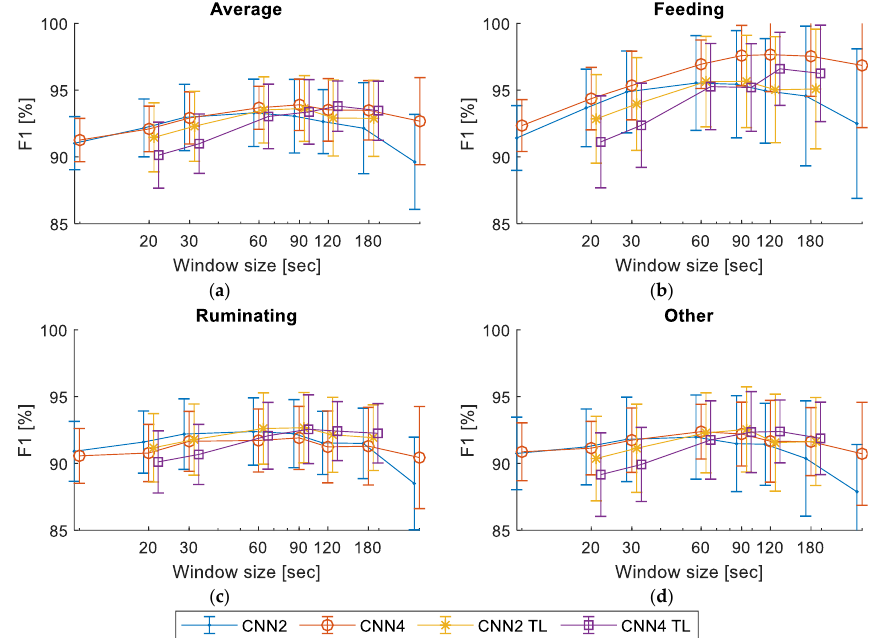
Figure 6. Performance of the tested models, CNN2 and CNN4, trained using randomly initialized model weights and by transfer learning (CNN2 TL and CNN4 TL), depending on the window size for the average F1 ( a ), feeding ( b ), rumination ( c ) and other behavior ( d ). The error bars represent the STD for 10-fold validation. The best accuracy scores of all classifiers trained with the full dataset for a window size with the highest average F1 score for each model are presented in Table 2. There were only minor differences in performance between the simpler CNN2 and the more complex CNN4 and between using transfer learning and training using randomly initialized model weights. For all the tested models, the clear optima were in the 60–120 s range. Table 2. Comparison of model performance trained by simple training and transfer learning. Preci- sion, F1 and recall values are given averaged (mean ± STD) for a 10-fold validation for optimal win- dow sizes (WS), presented in Figure 6a.